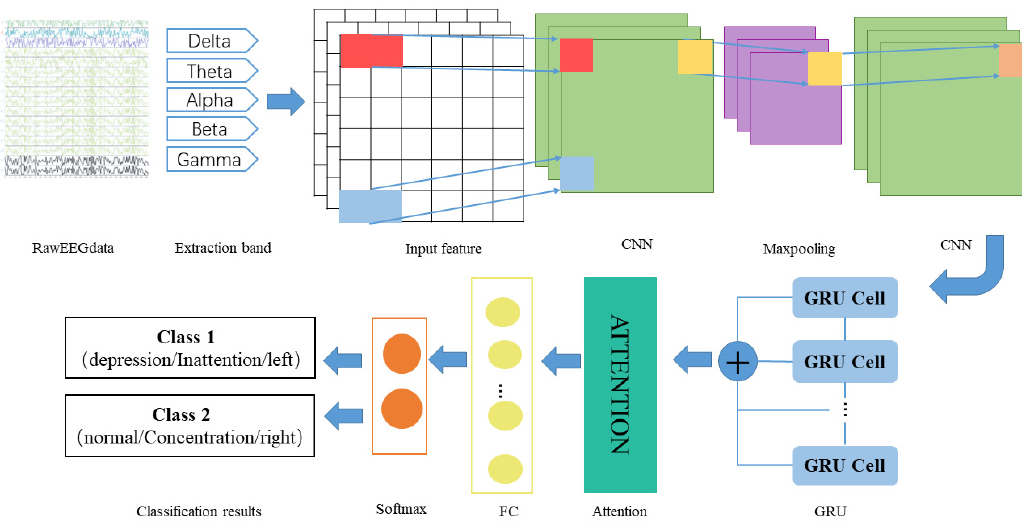
Figure 5. The structure of the hybrid network.